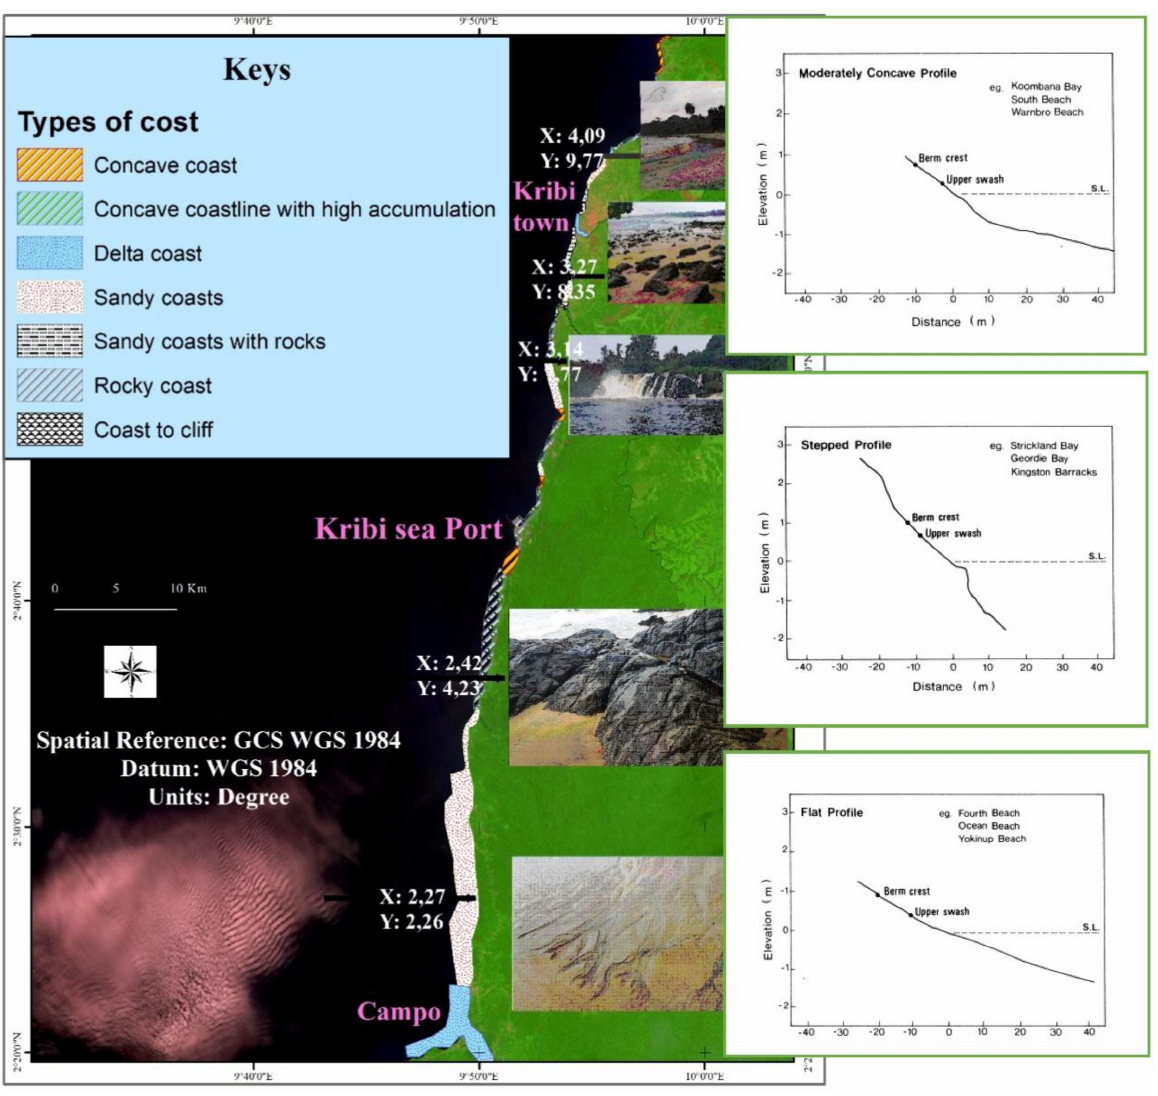
Figure 4. Kribian types and morphotypes of the coast. These figures show an alternation between sandy low coast (flat and concave morphotype profiles) and rocky coast (stepped